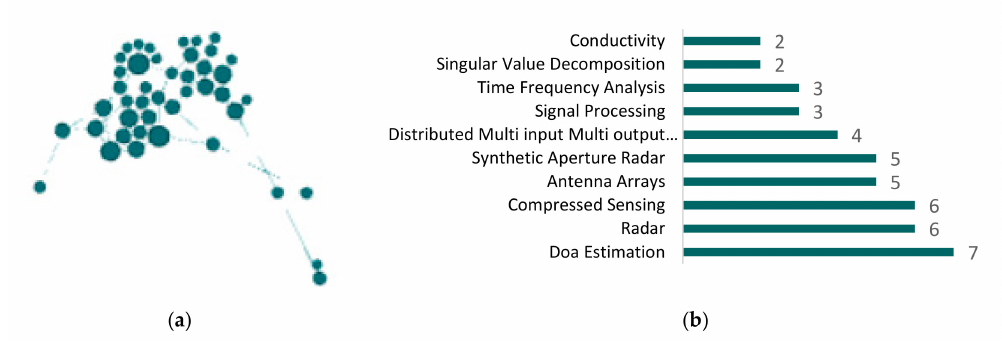
Figure 20. Representation of Direction of Arrivals (DOA) Estimation community: ( a ) Isolated distribution of publications. ( b ) Keywords of the